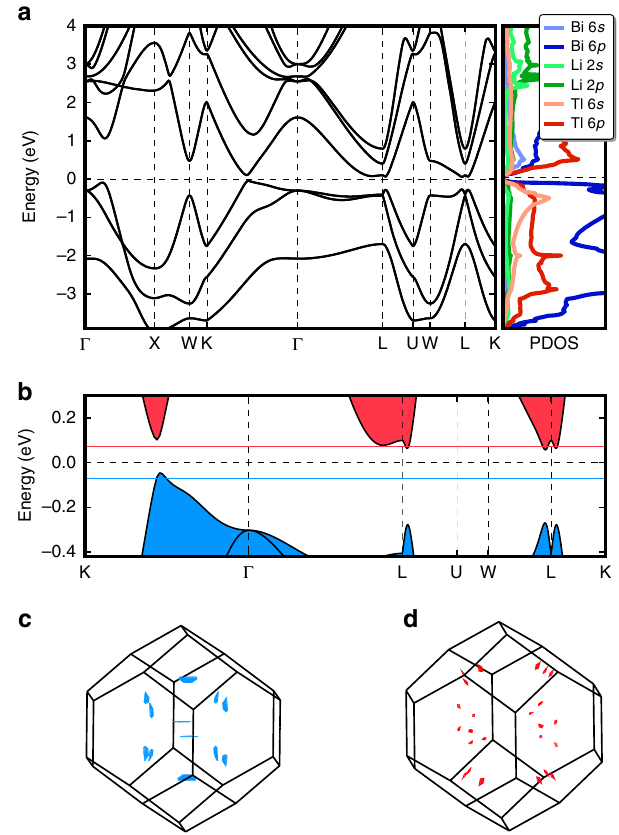
Fig. 2 Electronic structure of Li 2 TlBi. a Band structure (left) and density of states (right) of Li 2 TlBi. b Expanded view of the band structure around the Fermi level. c Fermi surface of hole doped Li 2 TlBi. d Fermi surface of electron doped Li 2 TlBi. Note the size of Fermi pockets in electron doped Li 2 TlBi are re-scaled by a factor of two for the purpose of visualization. The Fermi level in the band structures is shifted to zero